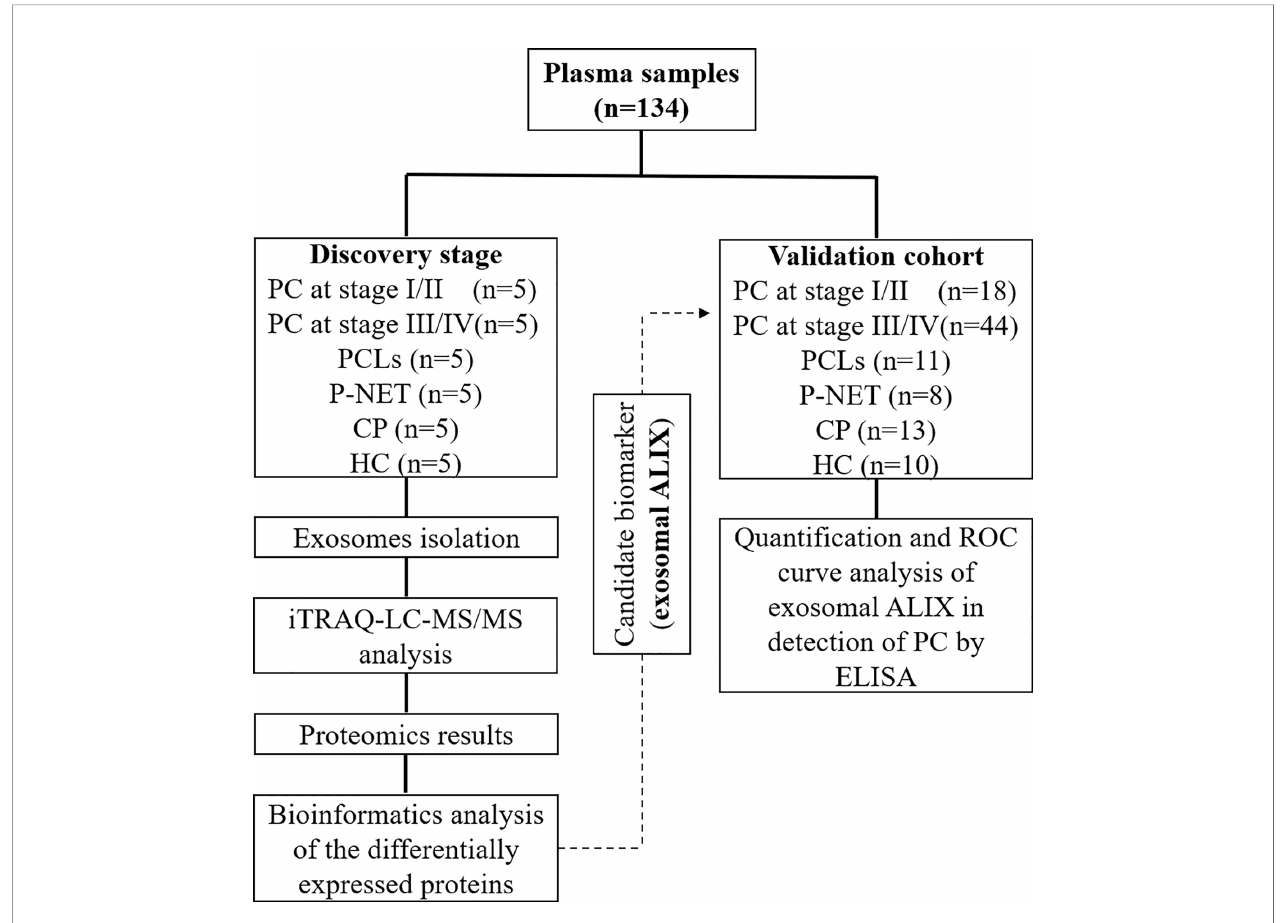
FIGURE 1 | Schematic work fl ow of the